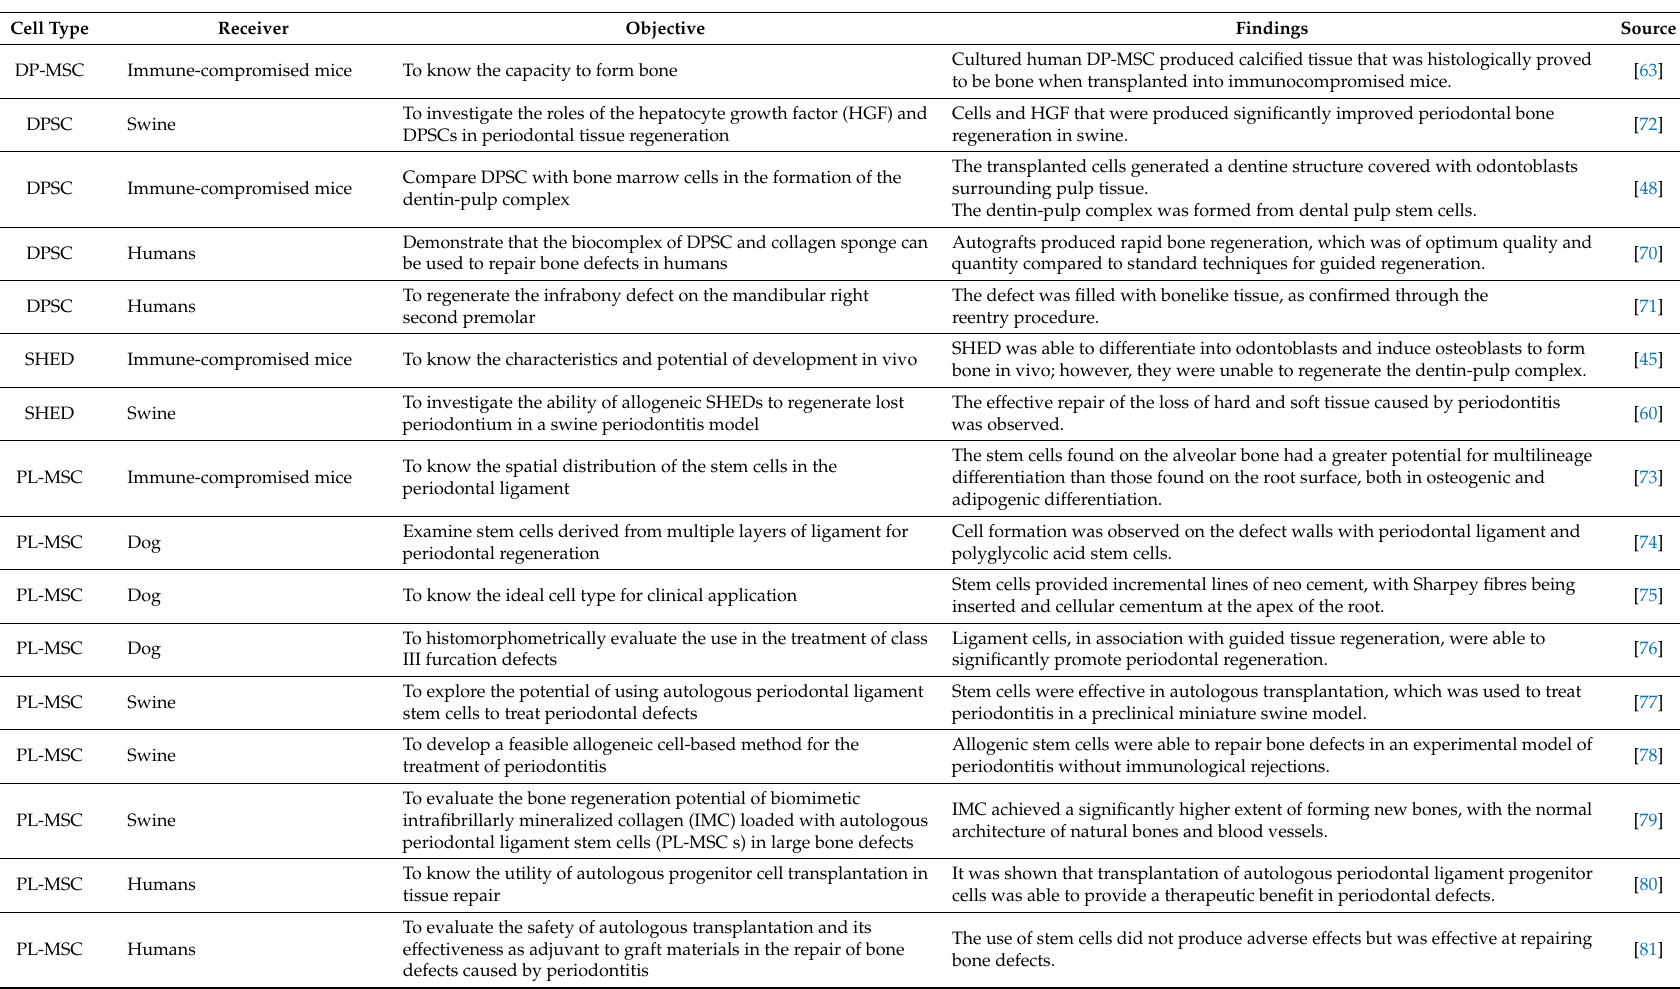
Table 1. Studies on the application of dental stem cells in the repair of bone defects caused by